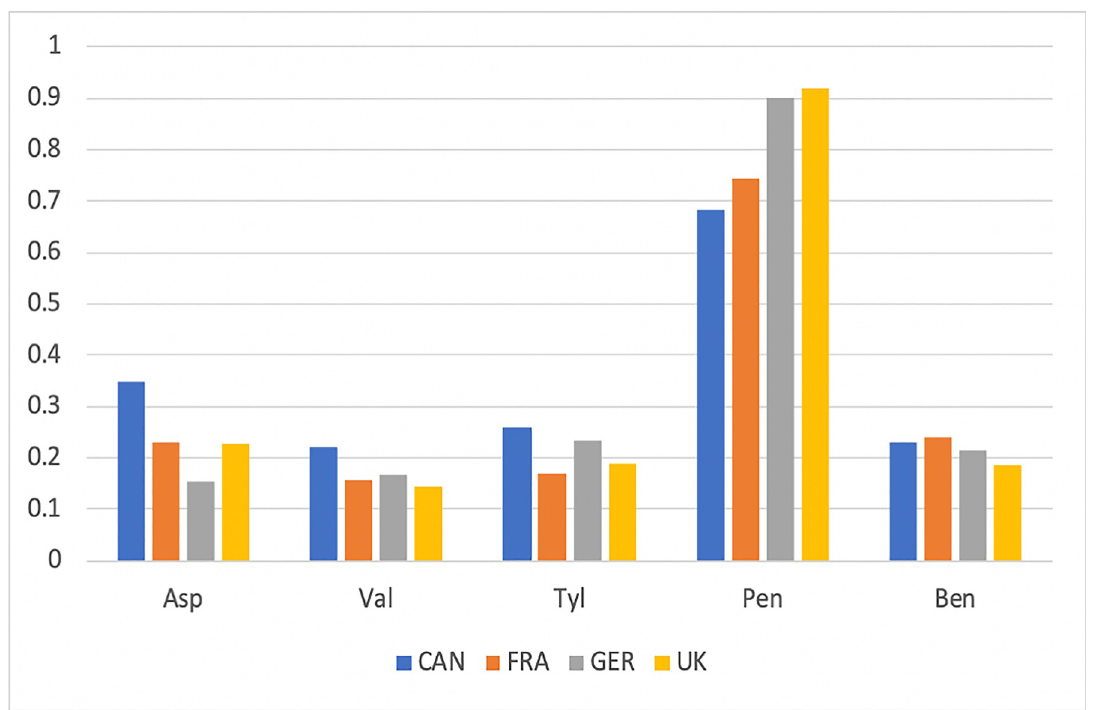
Fig 4. Histogram showing the results of analysis of Survey 1 for the penicillin question discussed in the text for France, Germany, Canada and the United Kingdom. The choices to the question "Which of these is an antibiotic? Select as many as you like!" were aspirin (Asp), Valium (Val), Tylenol (Tyl), penicillin (Pen) and Benadryl (Ben). Four countries were examined in this initial step–United Kingdom (UK), Germany (GER), France (FRA) and Canada (CA). The Y axis shows the percent of respondents giving the indicated